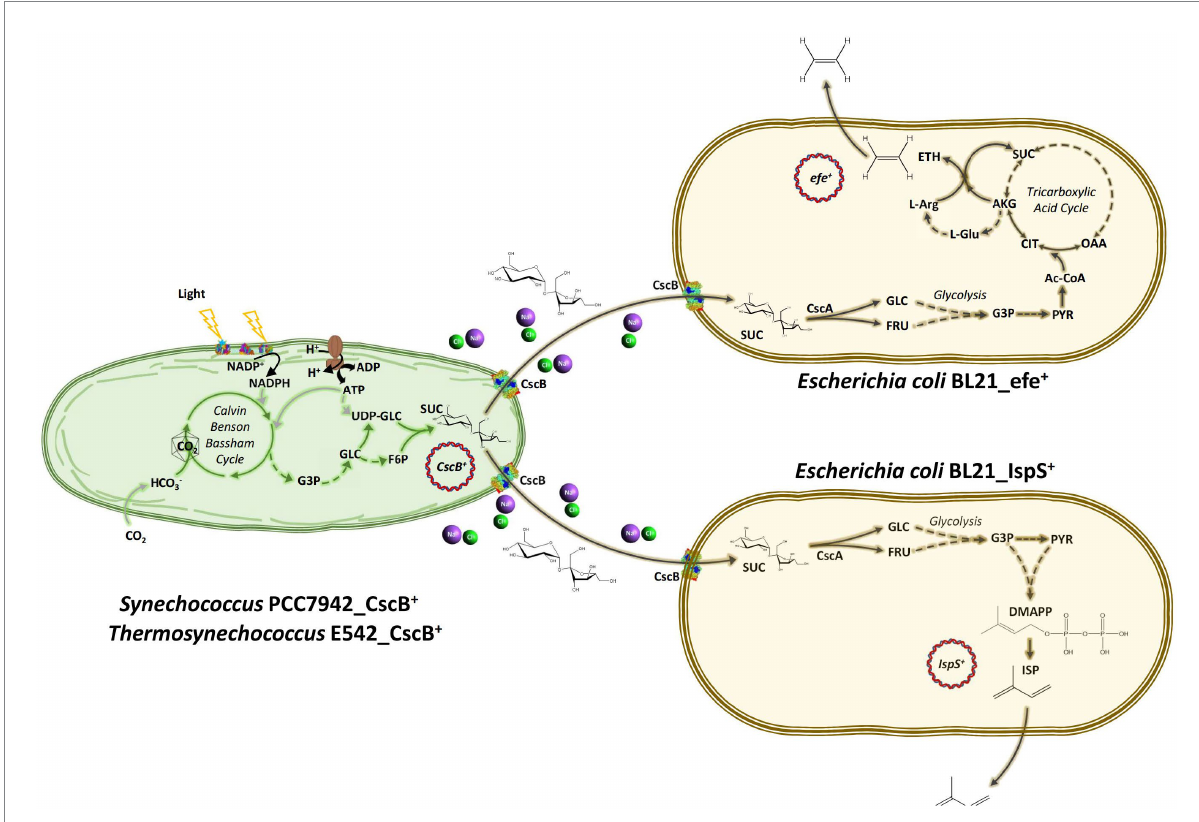
FIGURE 1 Schematic diagram of the artificial consortium system used in this study. Thermosynechococcus E542 and Synechococcus PCC7942 engineered to secrete sucrose under osmotic stress to support the growth of transgenic Escherichia coli strains capable of the synthesis of ethylene or isoprene. CO 2 , carbon dioxide; HCO 3 − , bicarbonate; G3P, glyceraldehyde 3-phosphate; GLC, glucose; FRU, fructose; PYR, pyruvate; UDP-Glc, uridine diphosphate glucose; F6P, fructose 6-phosphate; SUC, sucrose; Ac-CoA, acetyl CoA; CIT, citrate; AKG, alpha ketoglutarate; SUC, succinate; OAA, oxaloacetate; L-Glu, glutamate; L-Arg, L-Arginine; ETH, ethylene; DMAPP, dimethylallyl pyrophosphate; ISP, isoprene; ATP, adenosine triphosphate; ADP, adenosine diphosphate; NADP + , oxidized nicotinamide adenine dinucleotide phosphate; NADPH, reduced nicotinamide adenine dinucleotide phosphate; CscB, sucrose permease; CscA, sucrose hydrolase; IspS, isoprene synthase; and efe, ethylene forming